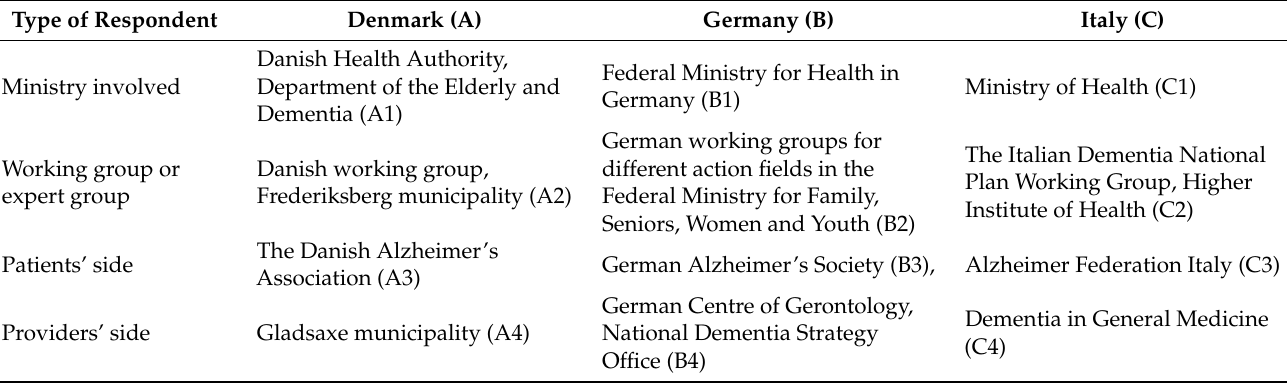
Table 2. Respondents sorted by stakeholder group (respondent